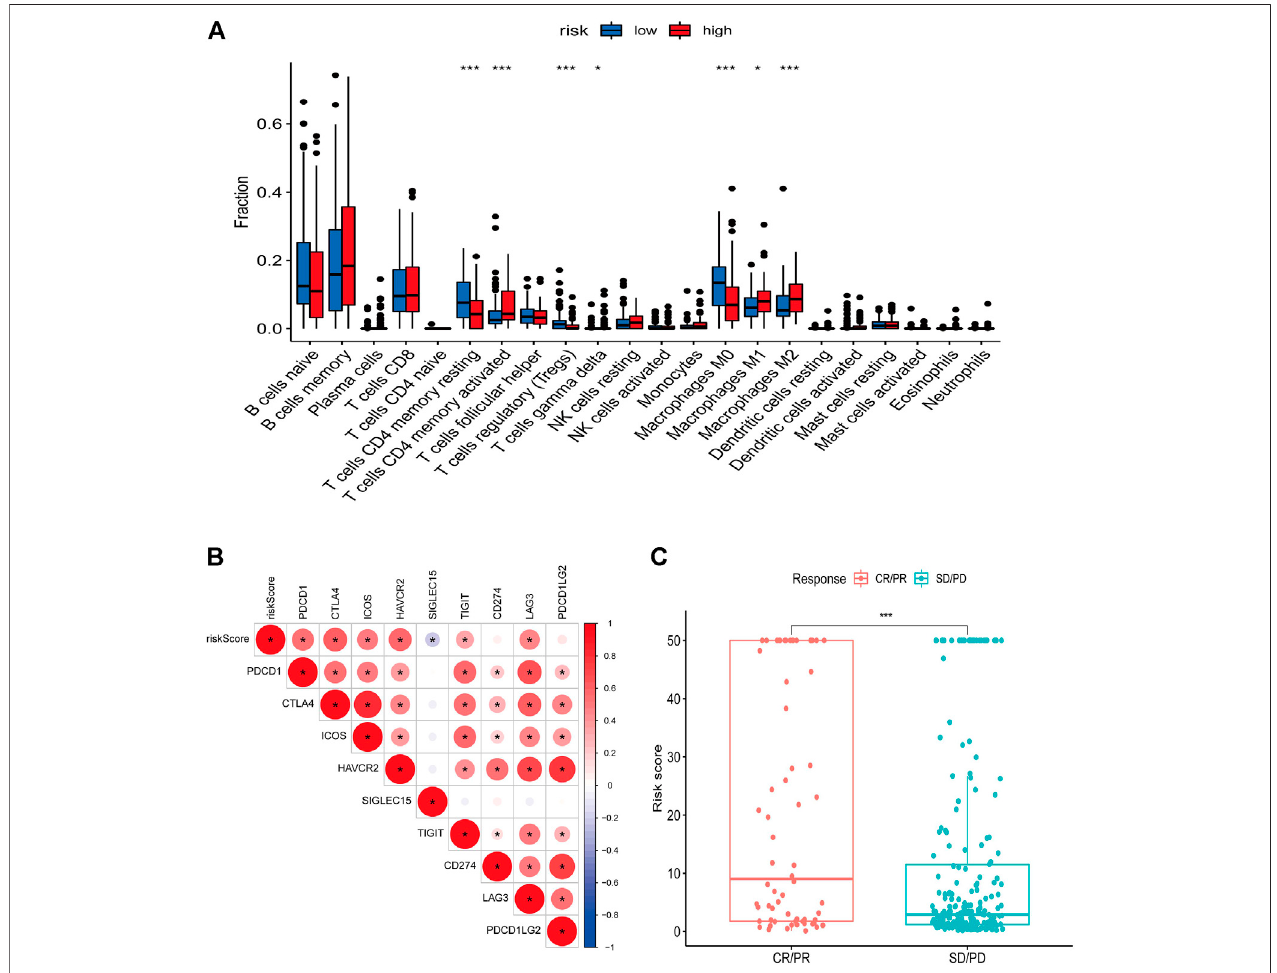
FIGURE8| Relationshipbetweenriskscoreandimmunelandscape. (A) Distributionof22immunecelltypesinhighandlowriskgroups. (B) Correlationmatrixheat map showing the correlation analysis of risk scores with immune checkpoint genes. (C) Boxplot showing the difference in the distribution of risk scores in different immunotherapy response